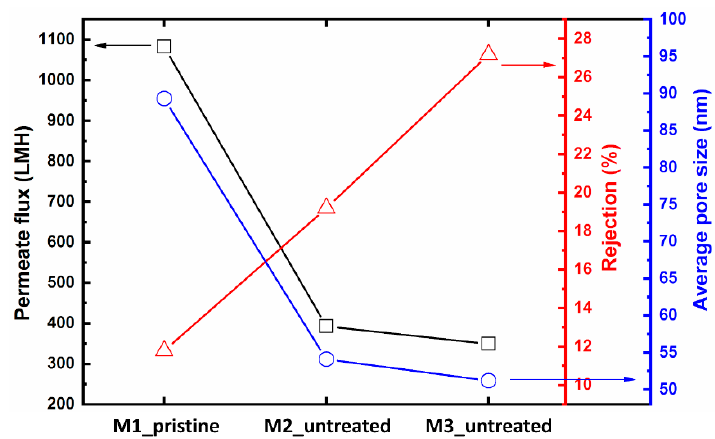
Figure 4. Pure water flux of patterned membranes replicated from the same hydrogel mold. In the first three castings, the mold was just washed with pure water and then reused.